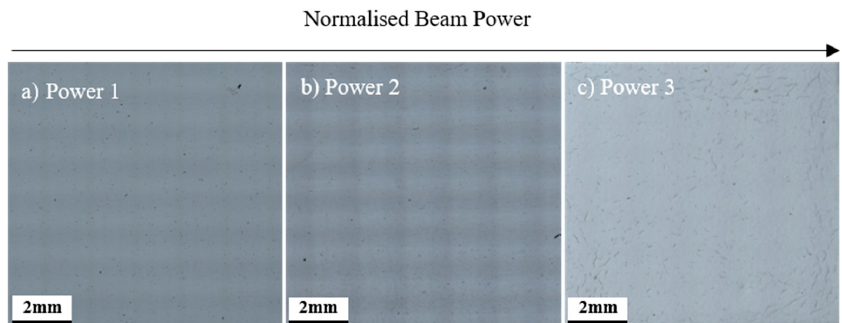
Figure 9. Stitched and blended high-resolution images of material discontinuities in the AB state in relation to normalised beam power.